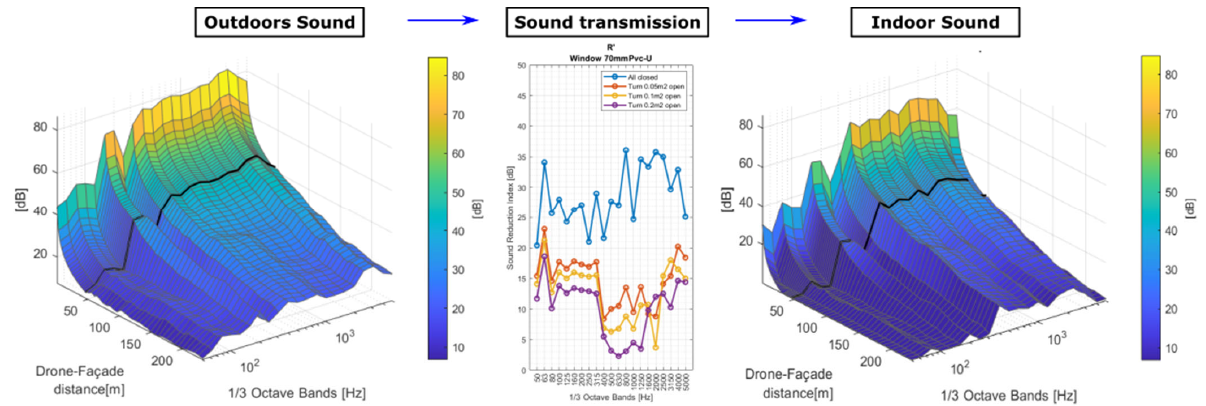
Figure 7. 𝐿𝐴 (cid:3040)(cid:3028)(cid:3051) by frequency as a function of the drone/façade distance 𝒓 , outdoors ( left ) and in ‐ Figure 7. LA max by frequency as a function of the drone/façade distance r , outdoors ( left ) and doors ( right ) through the assumed partition ( 0.05 𝑚 (cid:2870) window open area). The measured apparent indoors ( right ) through the assumed partition (0.05 m 2 window open area). The measured apparent sound reduction index 𝑅′ of the partition due the glazing open area is included ( middle ); adapted sound reduction index R (cid:48) of the partition due the glazing open area is included ( middle ); adapted with permission from Ref. [32]. with permission from Ref.